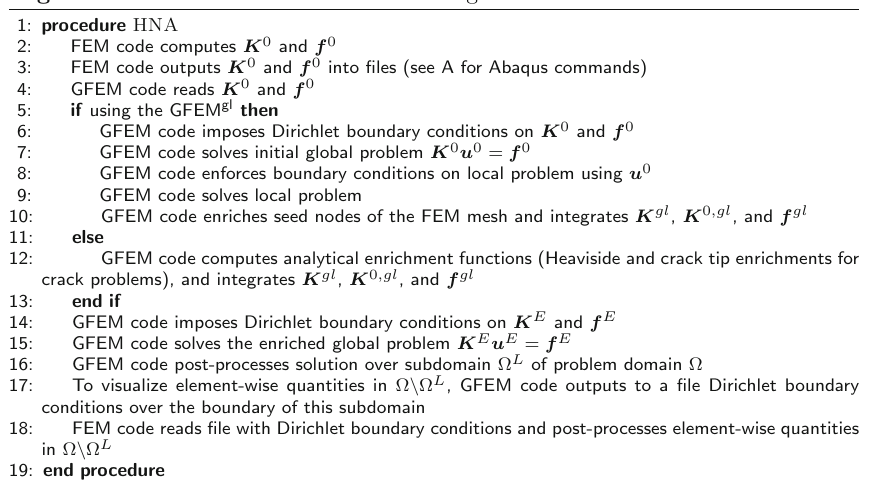
Algorithm 1 Hierarchical Non-Intrusive